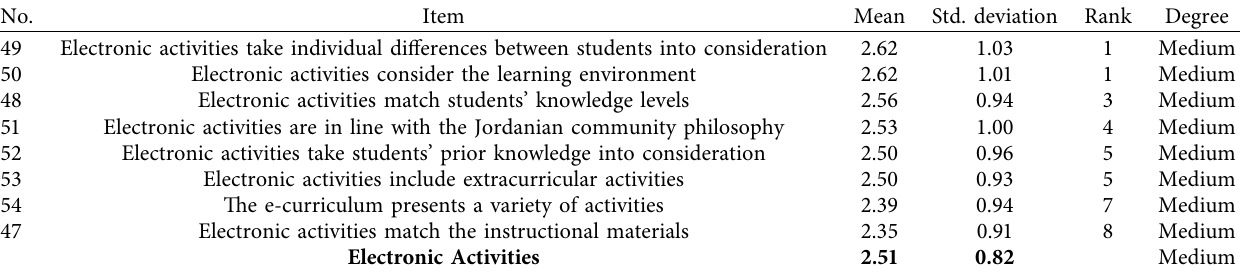
Table 4: Means, standard deviations, ranks, and degree of the study sample on the field of Electronic Activities.